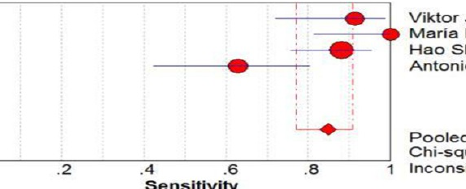
Figure 3. Methodological quality graph